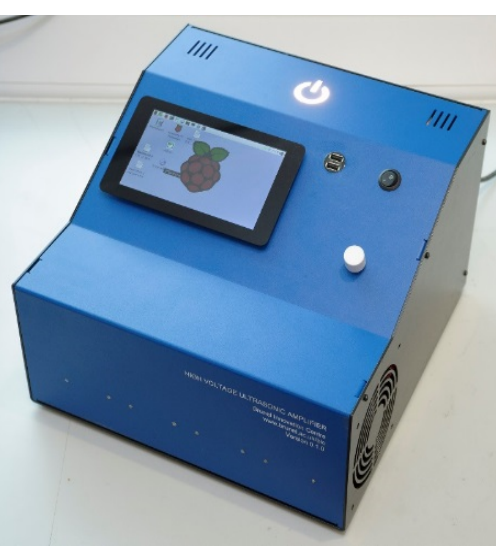
Figure 6. Bespoke High-Power Amplifier.